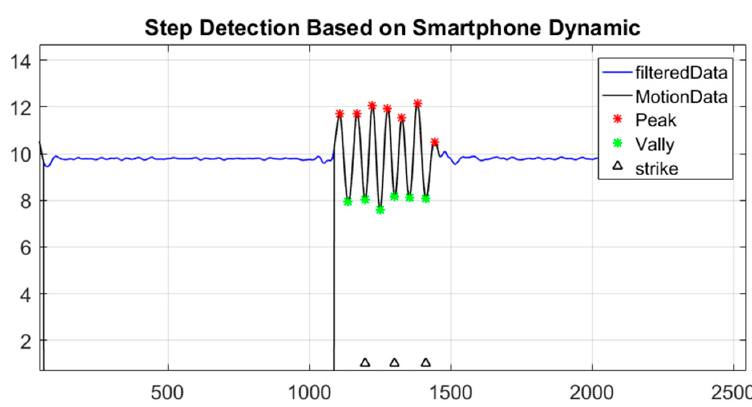
Figure 7. The Step Detection Result.